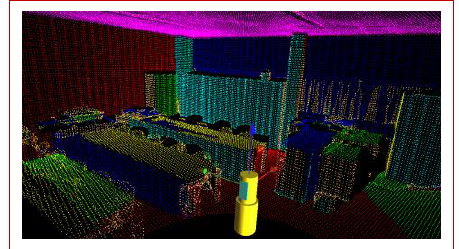
Figure 4. The segmented planar regions are shown in different colours.